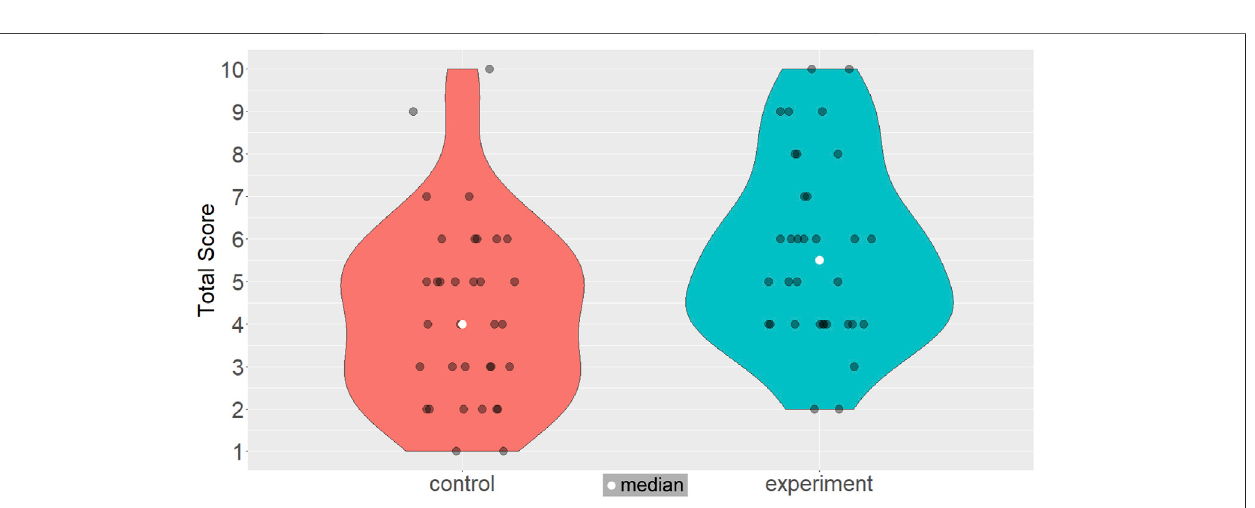
Frontiers in Virtual Reality |